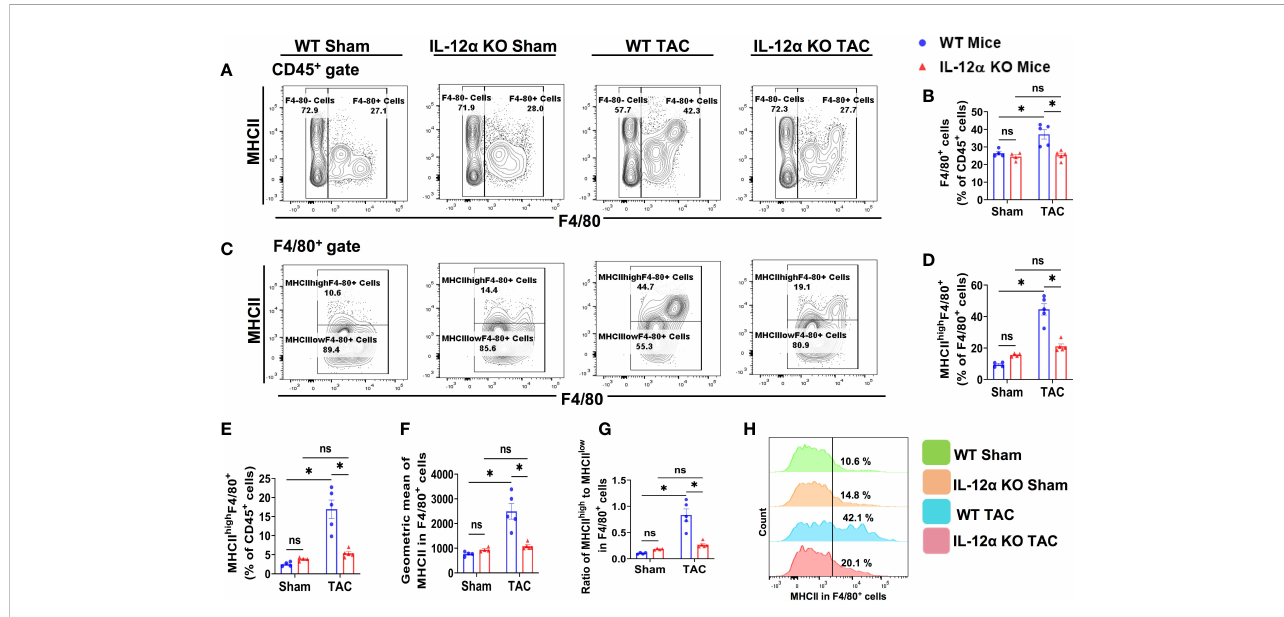
FIGURE 5 IL-12 a KO signi fi cantly attenuated TAC-induced pulmonary F4/80 + macrophage accumulation and polarization. (A) Flow cytometry plots of lung F4/80 + macrophages. (B) Quanti fi ed percentage of F4/80 + cells within CD45 + cells. (C) Flow cytometry plots for detecting MHCII expression in F4/80 + cells. (D, E) The percentages of MHCII high F4/80 + cells within F4/80 + or CD45 + cells. (F) Mean fl uorescent intensity of MHCII in F4/80 + cells. (G) Ratio of MHCII high to MHCII low in F4/80 + cells. (H) Representative histograms of MHCII expression in F4/80 + cells. *p<0.05, ns, non-signi fi